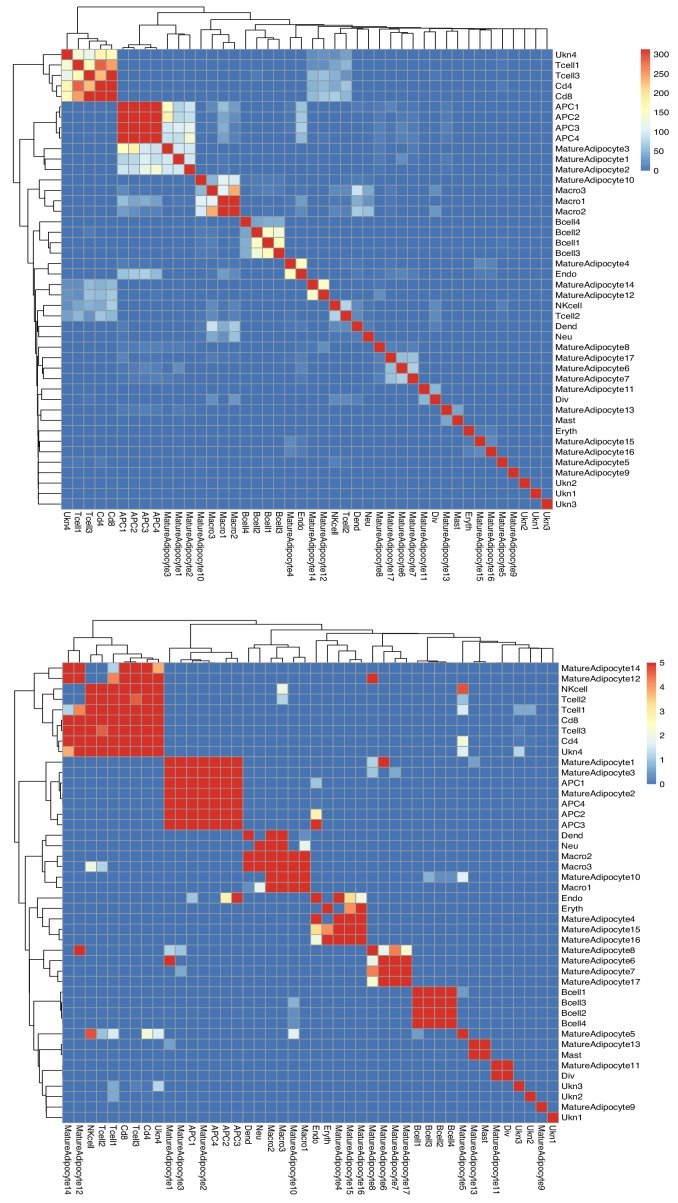
Multimodal analysis of SVF and adipocyte single-cell sequencing data.Hierarchical plot showing correlation of single cell/nuclei gene expression between SVF and adipocyte clusters. Cell types from both mature adipocyte nuclei and SVF single cells were used in this analysis. They were grouped using hierarchical clustering with tiles colored by unadjusted (top) -Log10 Bonferroni adjusted p-values (bottom). Unadjusted (top) and adjusted (bottom) p-values were thresholded to aid in visualization with values less than 10−5 set to 10−5.